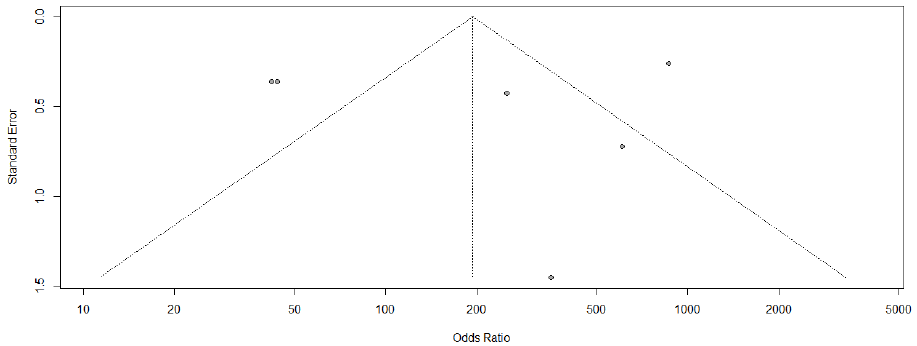
Figure 6. Funnel